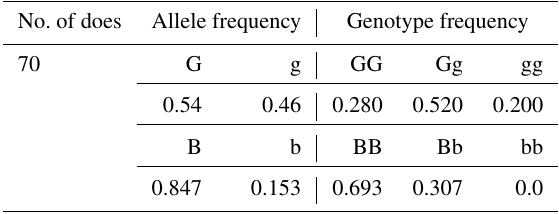
Table 3. Allele and genotype frequencies of the GDF9 gene and BMP15 gene.